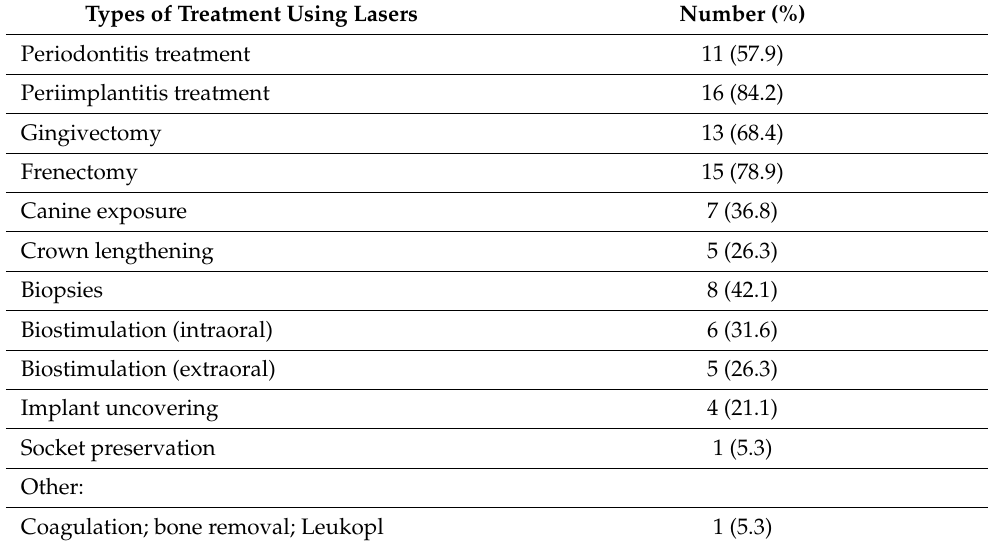
Table 2. Types of treatment provided with lasers in periodontics departments in the U.S. and Canada. Types of Treatment Using